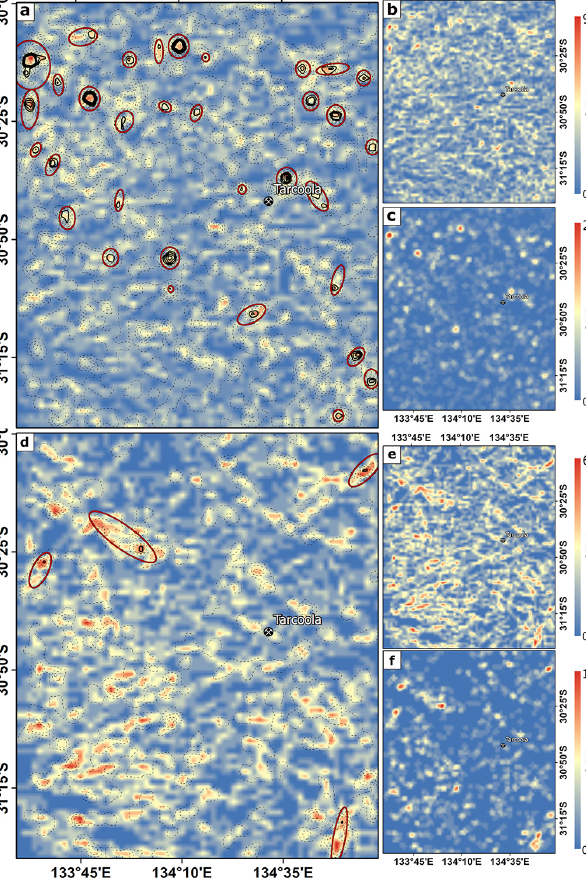
Figure 14. (a) Targeting map derived from “surface auto” and the “subsurface worms”. (b) Lineament density map (P20). (c) Inter- section density map (I20). (d) Targeting map derived from “surface auto” and the “subsurface auto”. (e) Lineament density map (P20). (f) Intersection density map (I20). Potential targeting areas that are located at the margins of the domain are indicated by red